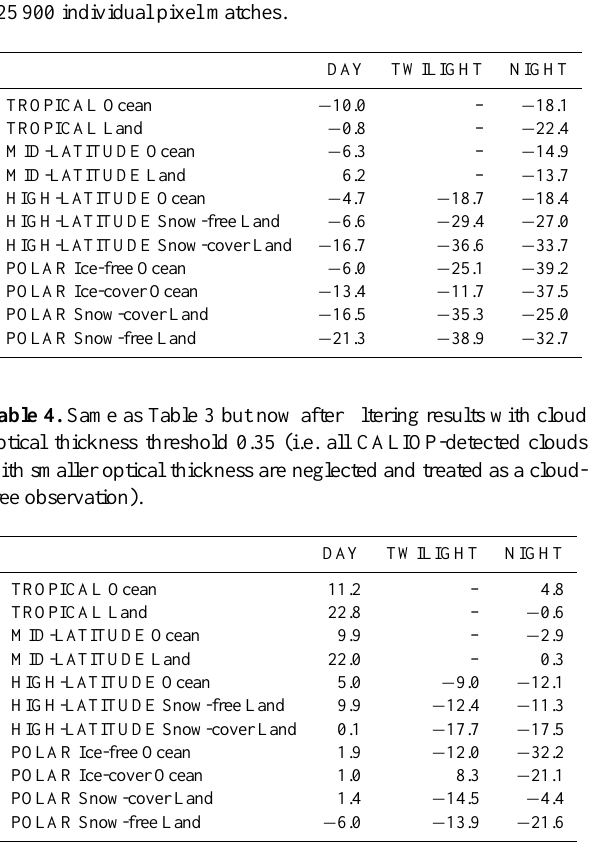
Table 3. Mean error (%) of cloud detection separated according to latitude bands and illumination categories (defined in the text) and surface conditions (land or ocean). Statistics computed from 99 full globally matched NOAA-18 and CALIPSO orbits with a total of 725900 individual pixel matches.